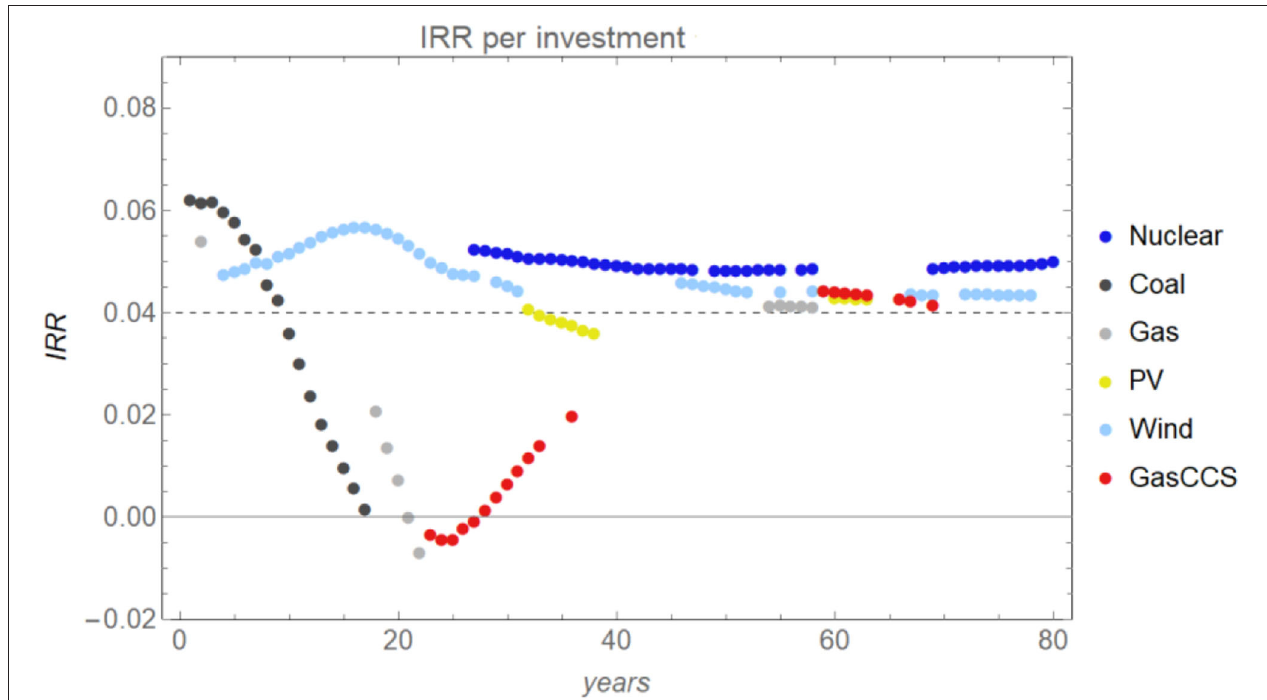
FIGURE 3 | Internal rate of return (IRR) in the base case [ f = 30% and i = 400M e . f is the fraction of an investment financed by a company’s own capital and i is the initial capital in a company’s bank account]. Each dot indicates the IRR of an investment made in a particular year. The horizontal dash line indicates the 4% bank interest